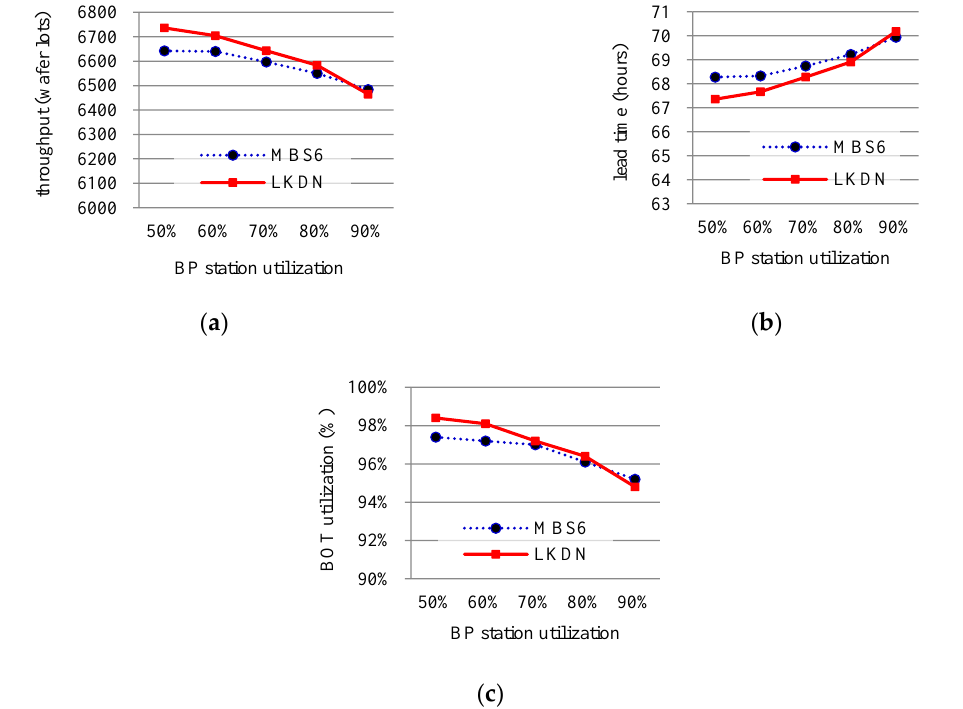
Figure 9. Performance of LKDN (Look-Downstream) and MBS6 (Minimum Batch Size 6) over different BP utilization levels in terms of ( a ) throughput, ( b ) production lead time, and ( c ) BOT (bottleneck) station utilization.